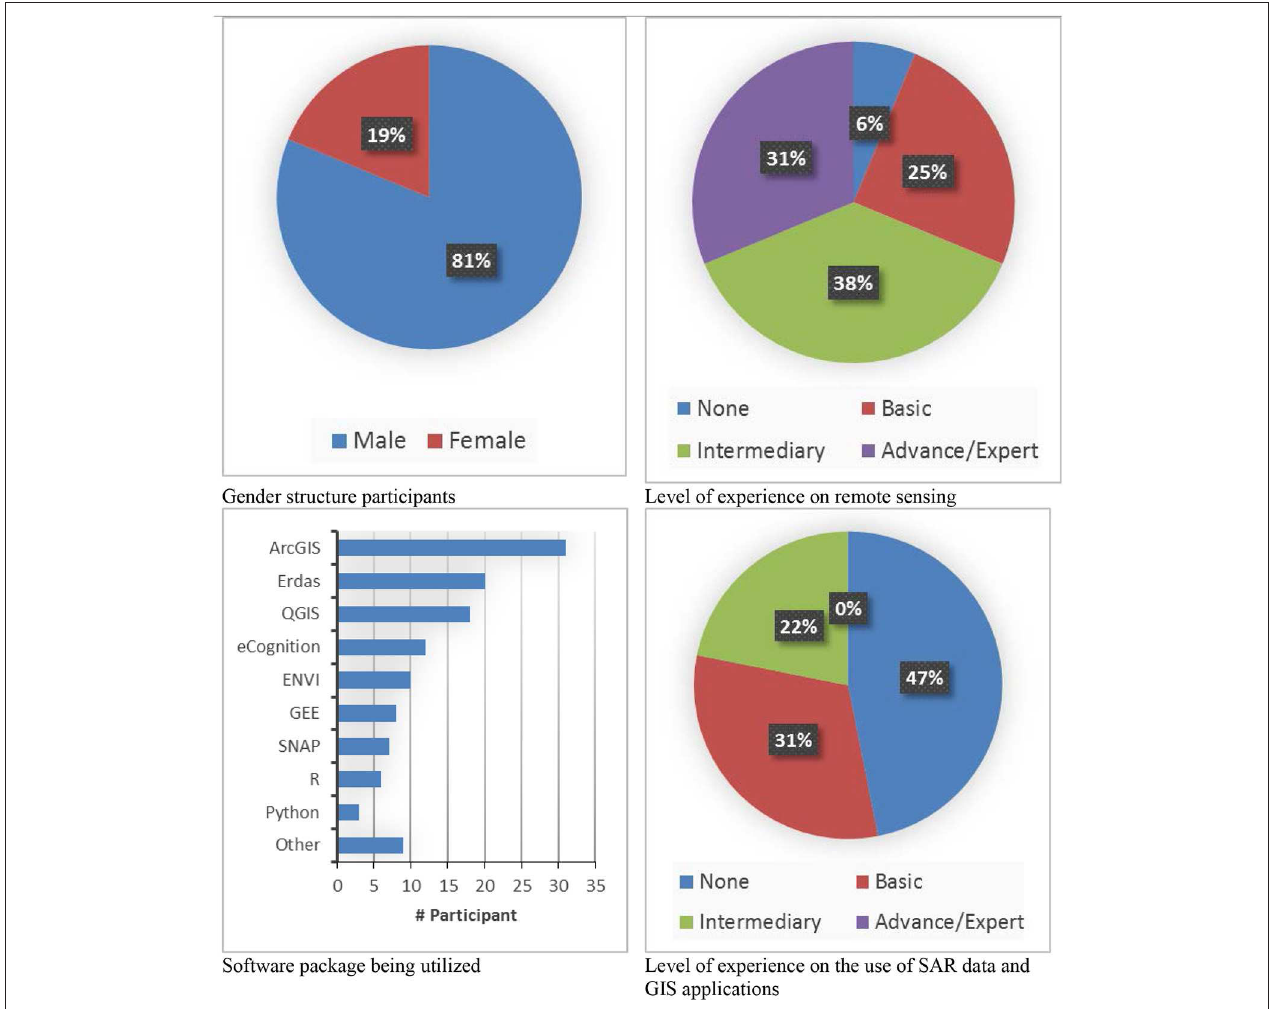
FIGURE 2 | Structural composition of the participants and their technical